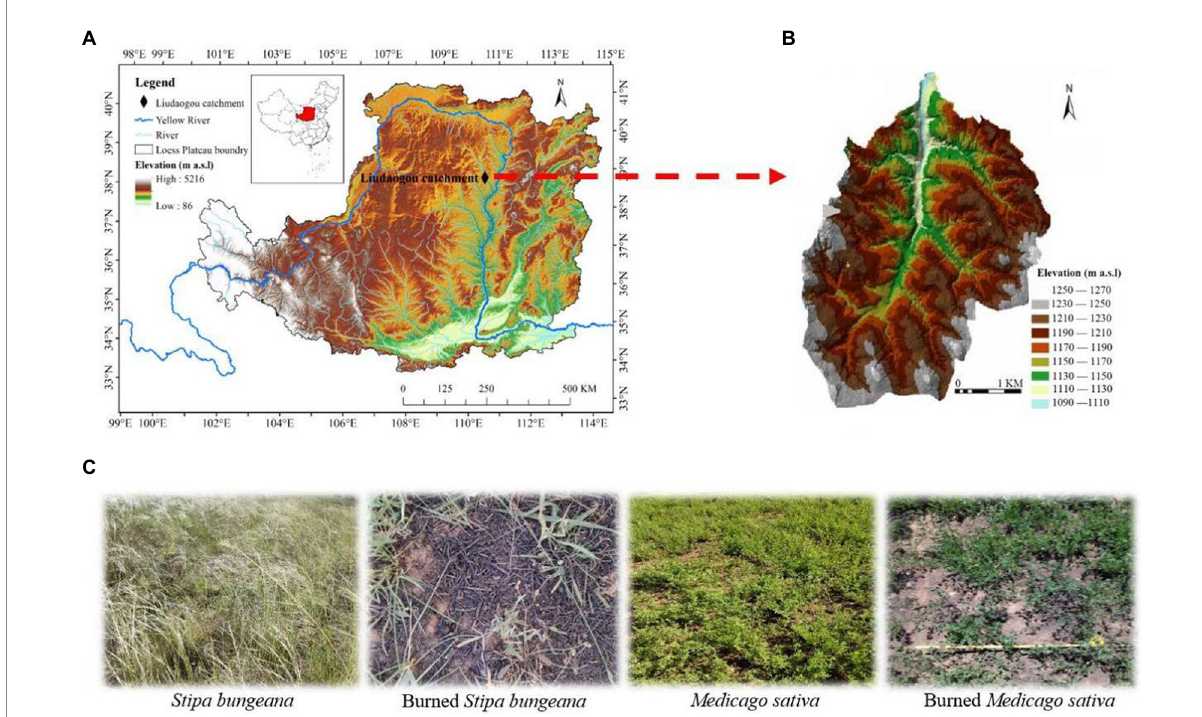
FIGURE 1 Location of the study site (A,B) , and selected habitat type (C) in Liudaogou Catchment, Loess Plateau region, China. The map was created in ArcGIS developed by Esri (Environmental Systems Resource Institute, ArcGIS 10.0; www.esri.com). The habitat type (C) was photographed in